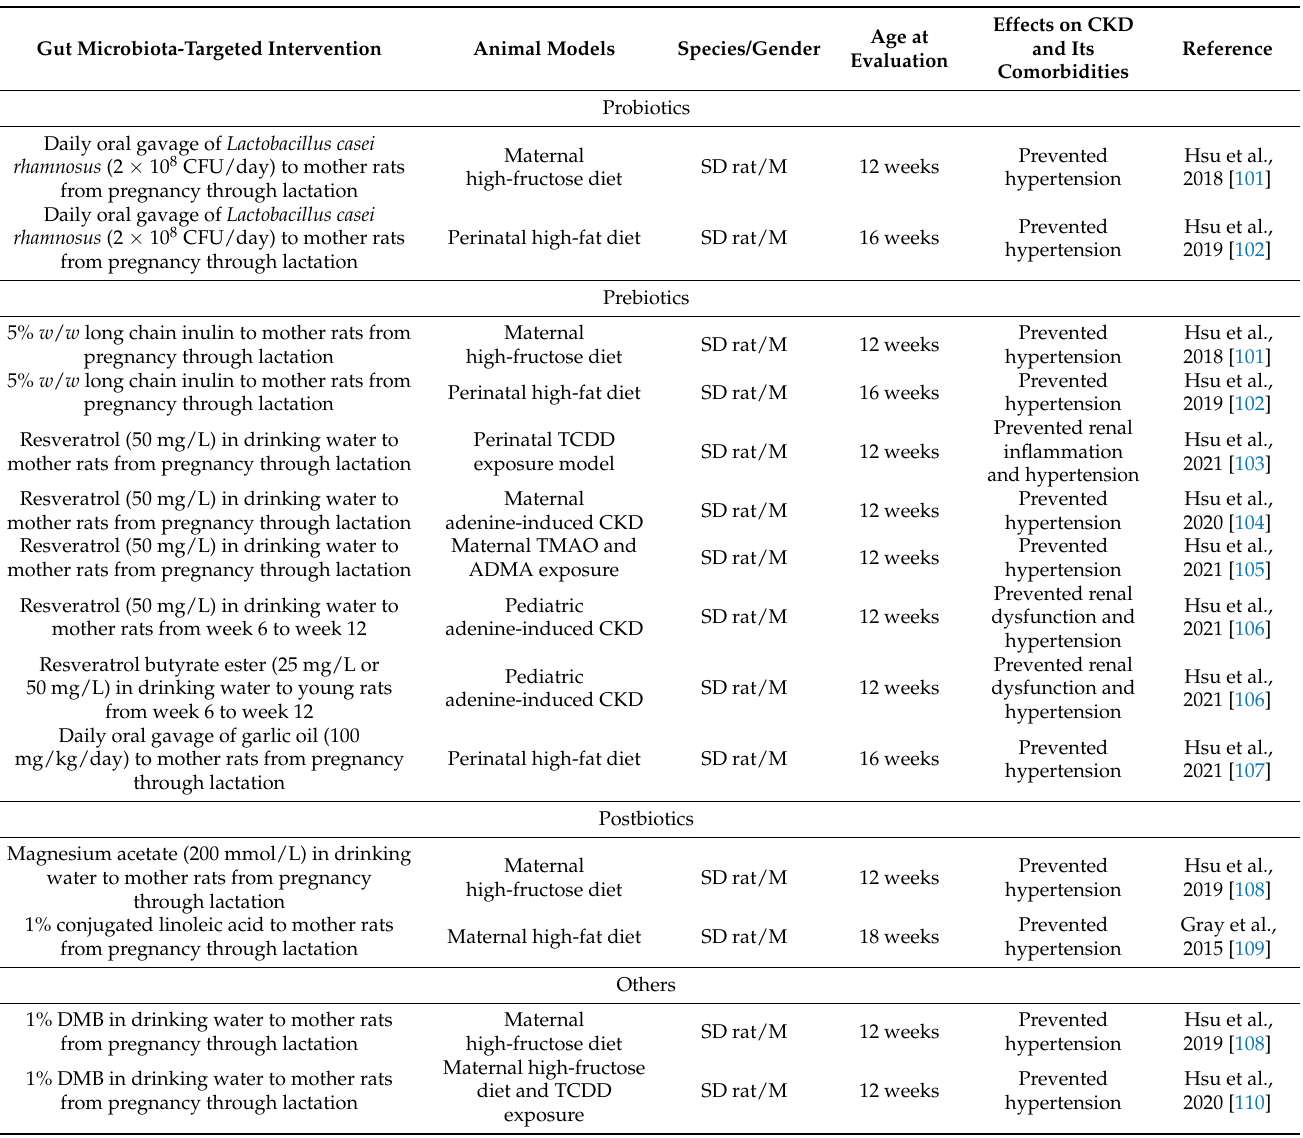
Table 2. Summary of early-life gut microbiota-targeted therapies for CKD and its